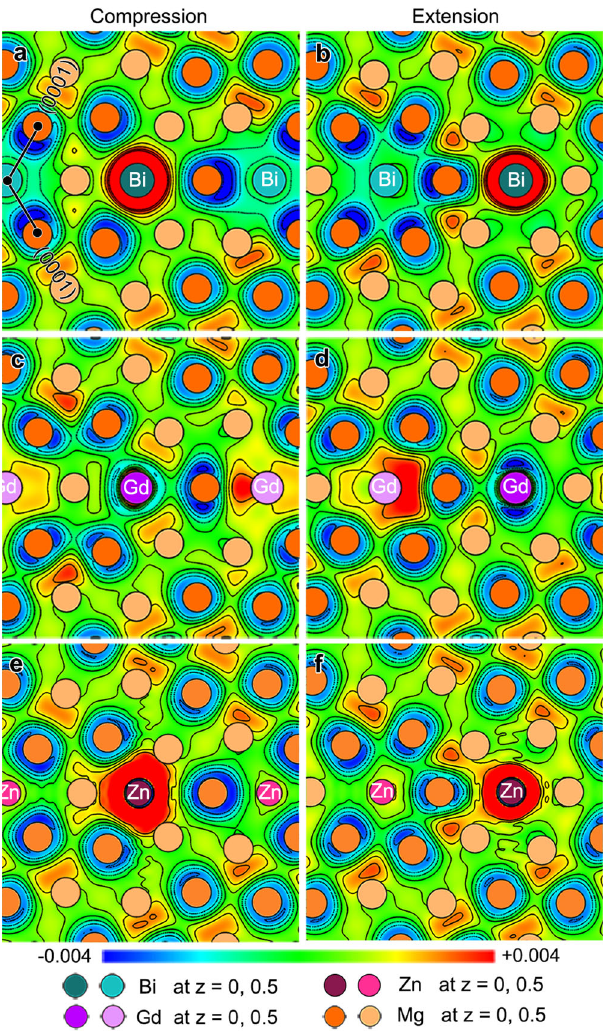
Fig. 4 Calculated results of differential electron charge density (DECD). (1120) plane contour maps of DECD of a , b Bi, c , d Gd, and e , f Zn segregated {1011} CTBs. The (1120) plane is close to the solute. The solute atoms in a , c , and e occupy compression sites in the CTB while those in b , d , and f are placed in extension sites. The black lines in a indicate (0001) planes of two crystals separated by {10 11} CTB. The unit of scale bar is eV/Å 3